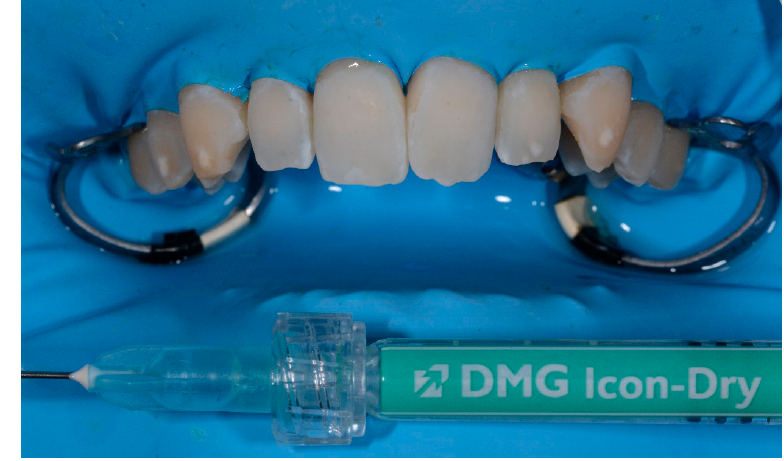
Figure 1. Application of ethanol.